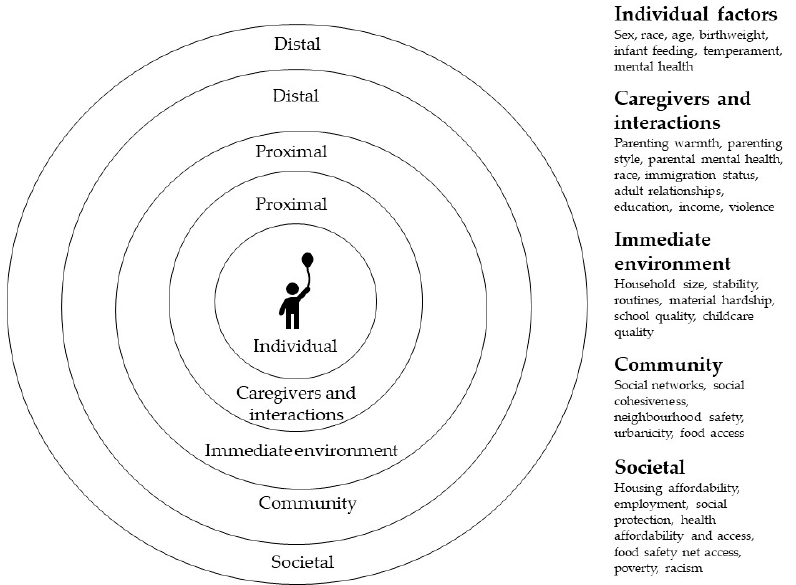
Figure 2. Socio-ecological proximal and distal factors impacting food security and child development (author